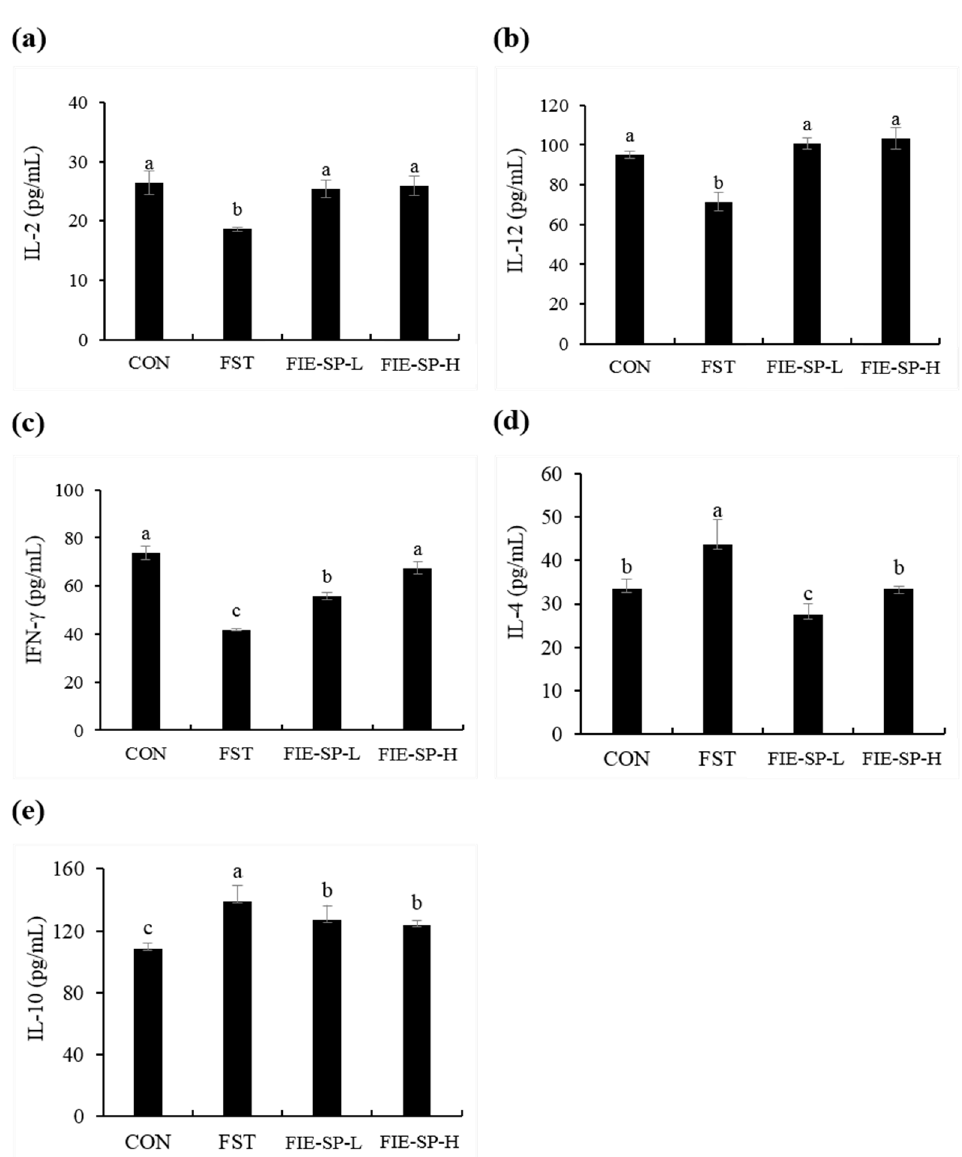
Figure 3. Effect of Salvia plebeia extract on the levels of C57BL/6 mouse splenocyte cytokines in the culture medium. Levels of Th1 cytokines ( a ) Interleukin-2 (IL-2), ( b ) IL-12, and ( c ) Interferon- γ (IFN- γ ) and Th2 cytokines ( d ) IL-4 and ( e ) IL-10 were determined using ELISA. Data are expressed as the mean ± S.E. Di ff erent letters in a column indicate statistical di ff erences based upon Duncan’s multiple range test ( p <